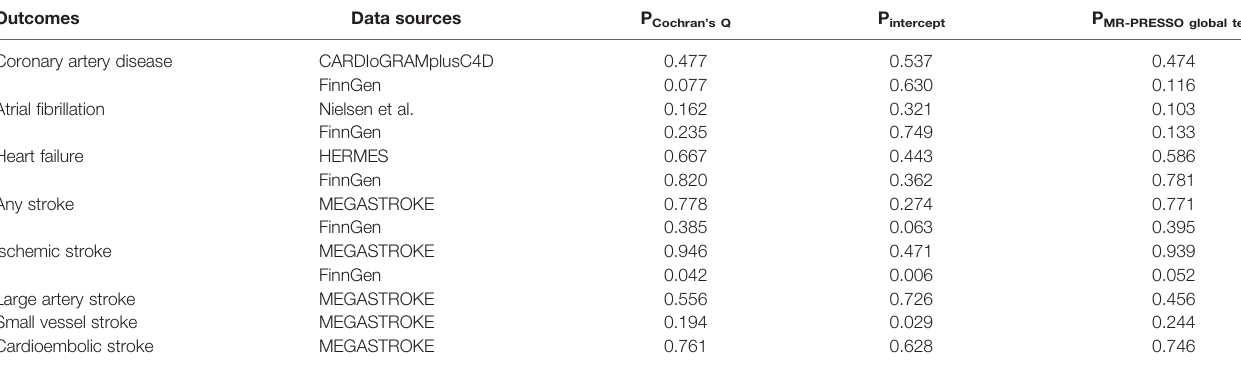
TABLE 2 | Sensitivity analyses of the causal associations of circulating a -Klotho levels with cardiovascular diseases.